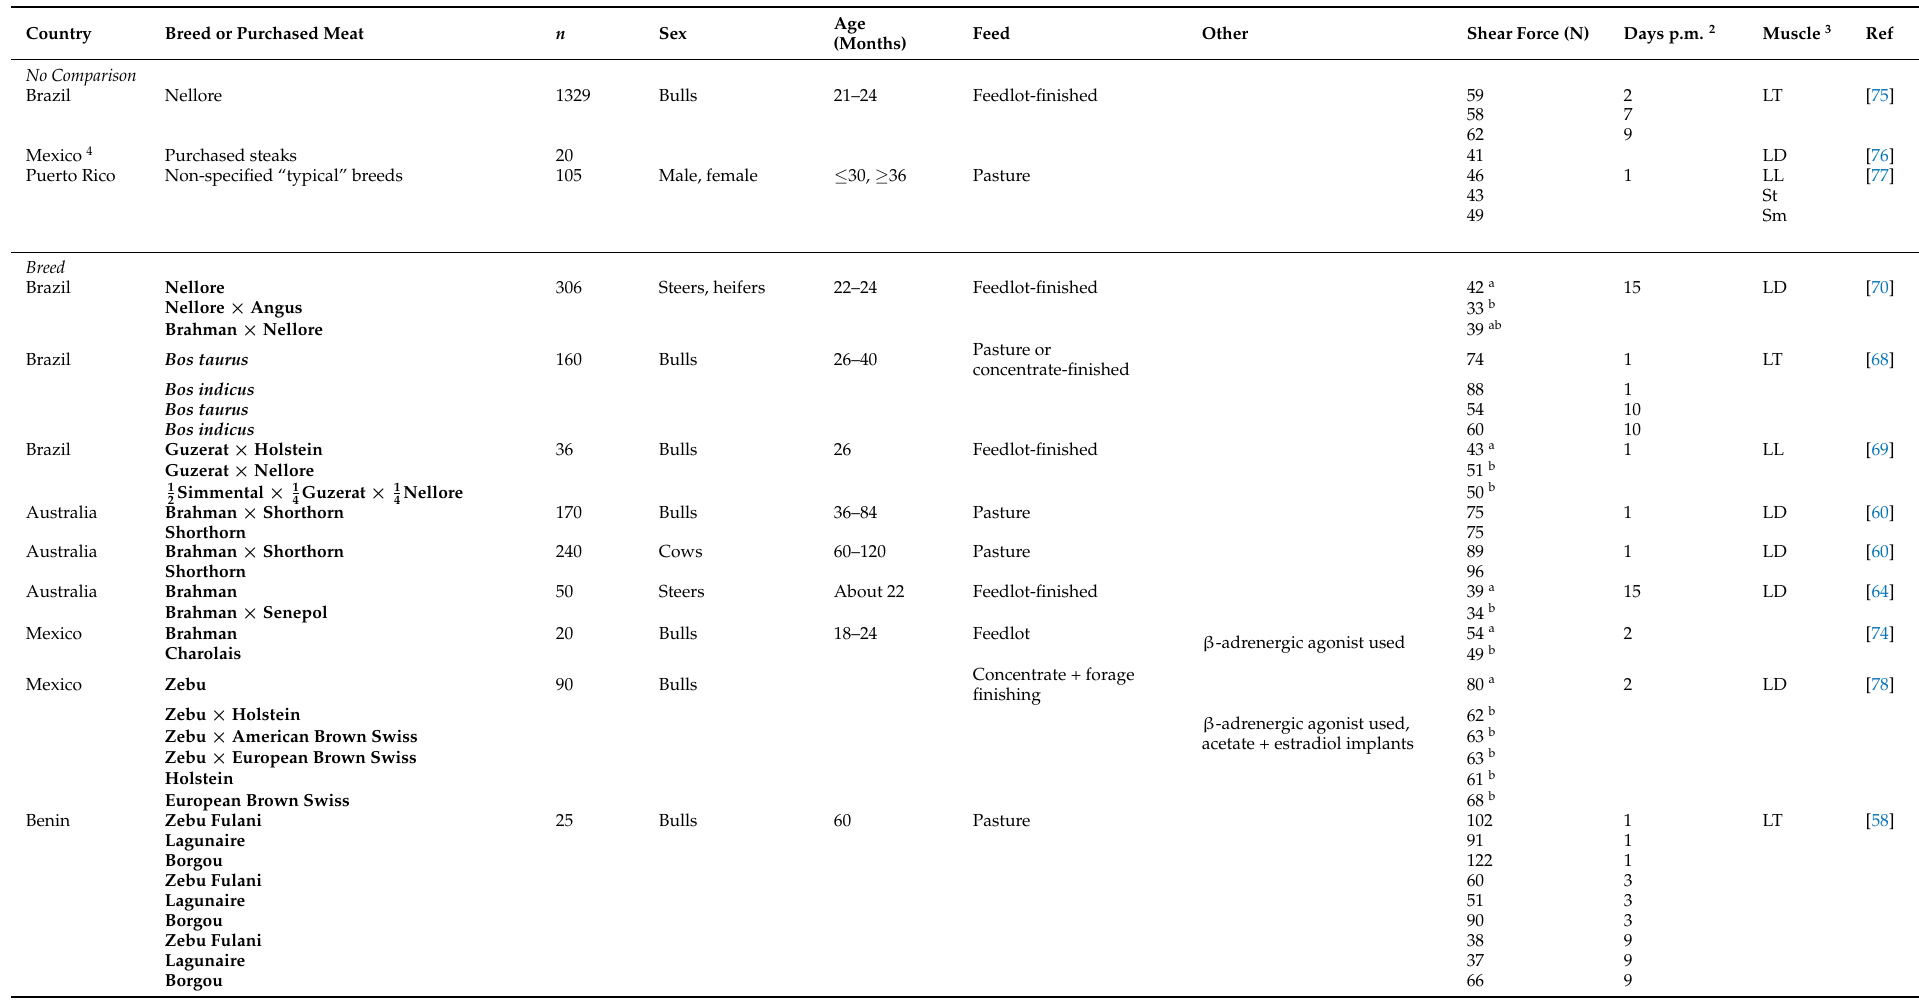
Table 1. Research on the impact of production factors, quality grade and aging time (treatments under study in bold) on the Warner Bratzler shear force (or equivalent) in meat from beef raised in tropical environments 1